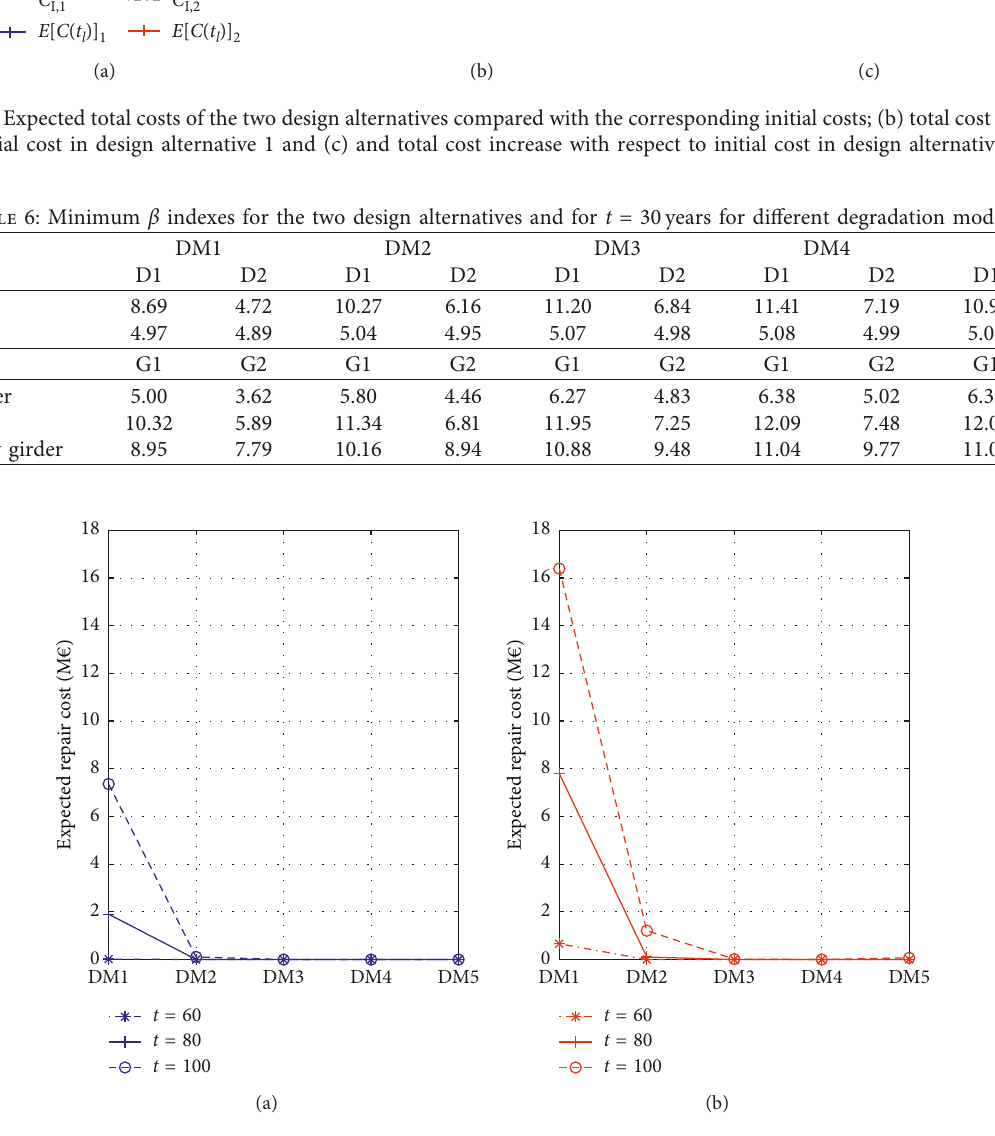
Figure 16: Expected repair costs for different deterioration models and for t